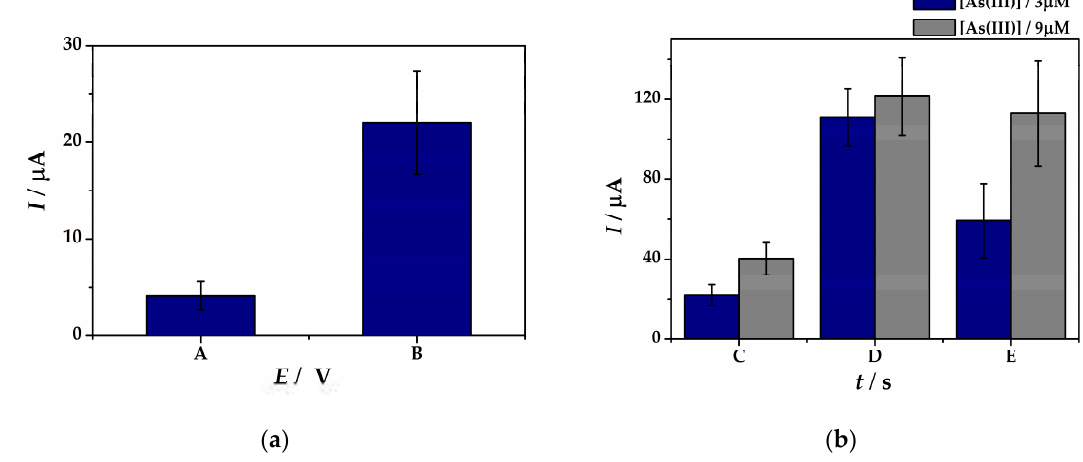
Figure 4. Peak current intensities obtained by means of SWASV measurements at ( IV )Au-PtNPs / SPCE from solutions containing 3 µ M As(III) (blue) and 9 µ M As(III) (grey) in 0.1 M KCl in 0.1 M HCl, (ii) using a cathodic pre-concentration ( a ) potential ( E dep ) of − 0.35 V (A) and − 0.50 V (B) at t dep = 120 s; and ( b ) time ( t dep ) of 120 s (C), 180 s (D), 240 s (E) at E dep = − 0.50 V.